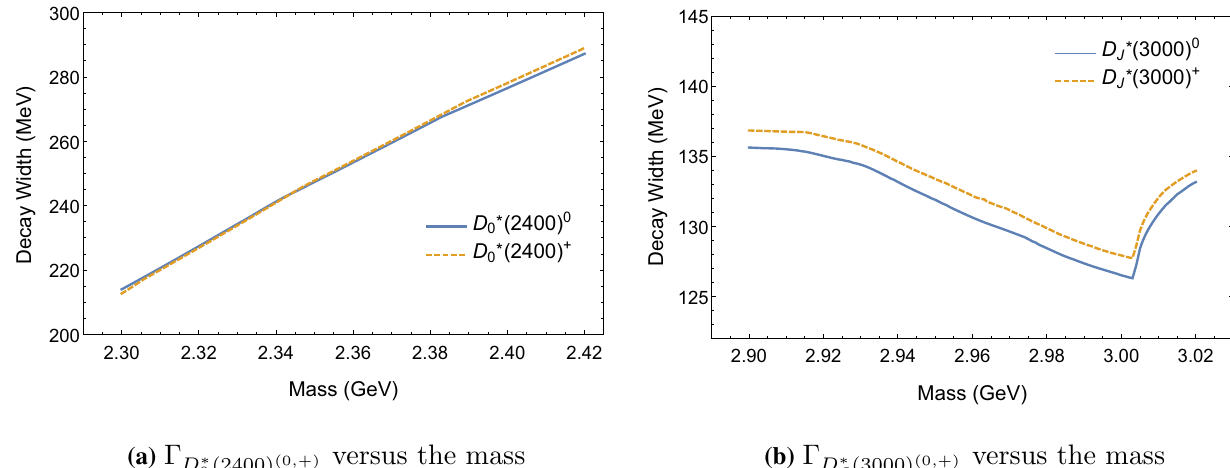
Fig. 3 Total decay widths of D ∗